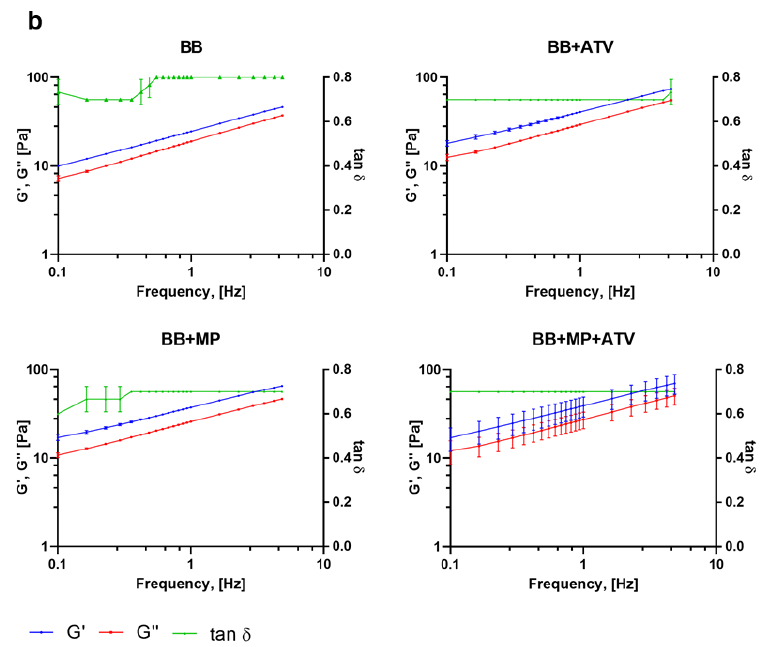
Figure 3. Frequency sweep of the formulations: ( a ) HA-Dop formulations, ( b ) BB formulations. N = 3. At an oscillation frequency of 1 Hz, all the gels have similar rheological properties; however, with increasing frequency, HA-Dop-based formulations remain stable throughout the sweep, while BB gels elastic modulus increases.